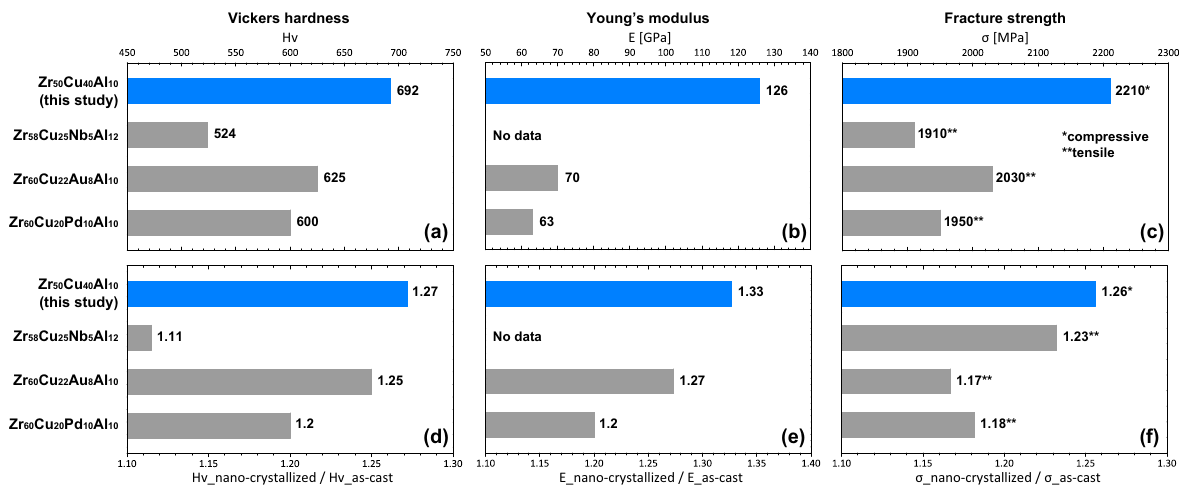
Fig. 10 Comparisons between the mechanical properties of nanocrystallized BMGs in the present study and previous ambient-pressure studies. a Vickers hardness ( H v), b Young ’ s modulus ( E ), and c fracture strength ( σ ) of the pHPQ Zr 50 Cu 40 Al 10 sample synthesized at 880 K and 5.5 GPa, Zr 60 Cu 20 Pd 10 Al 10 with the volume fraction of nanocrystals ( V f ) = 75% (ref. 27 ), Zr 60 Cu 22 Au 8 Al 10 with V f = 75% (ref. 27 ), and Zr 58 Cu 25 Nb 5 Al 12 with V f = 50% (ref. 26 ). Values of d H v, e E , and f σ normalized by the values for the as-cast